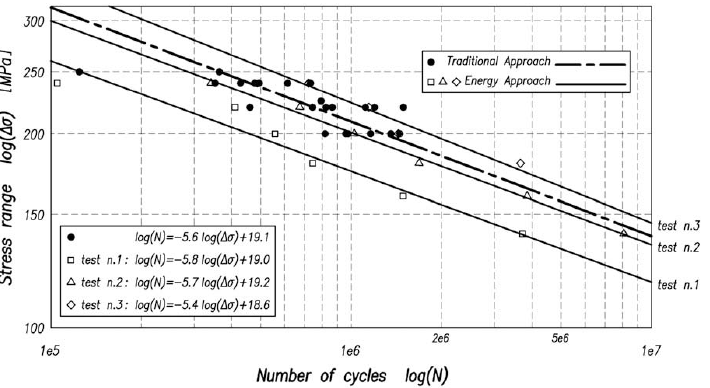
Figure 19. S–N curves obtained by traditional and energy approaches [30]. Reprinted with permission from ref. [30]. Copyright 2021 Elsevier.